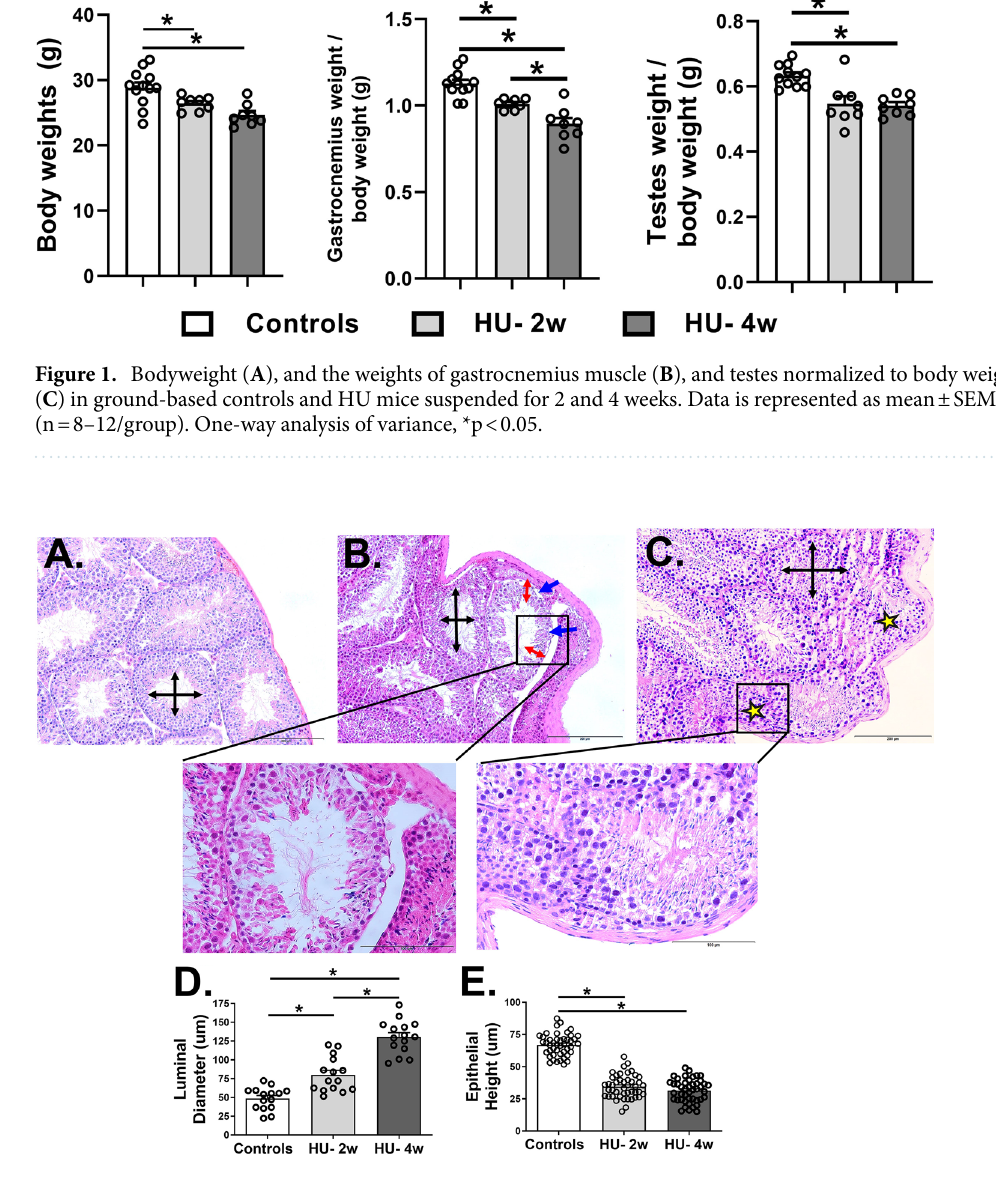
Figure 2. Histopathological features of testes tissues from ground-based controls ( A ) and HU mice suspended for two ( B ) and four ( C ) weeks. The image analysis shows the tubular diameter ( D ) and epithelial height ( E ) in the three groups of mice. The luminal diameter (black arrows) reduced epithelial height (red arrows), vacuolation (blue arrows), and the areas of necrosis (stars) are marked in the images. Data is represented as mean ± SEM (n = 15 images/group for 2D and 45 images/group for 2E, 8–12 mice/group). Images ( A , B ) were taken at 20 × magnification, while the zoomed-in inset images were taken at 40 × magnification. One-way analysis of variance, *p <